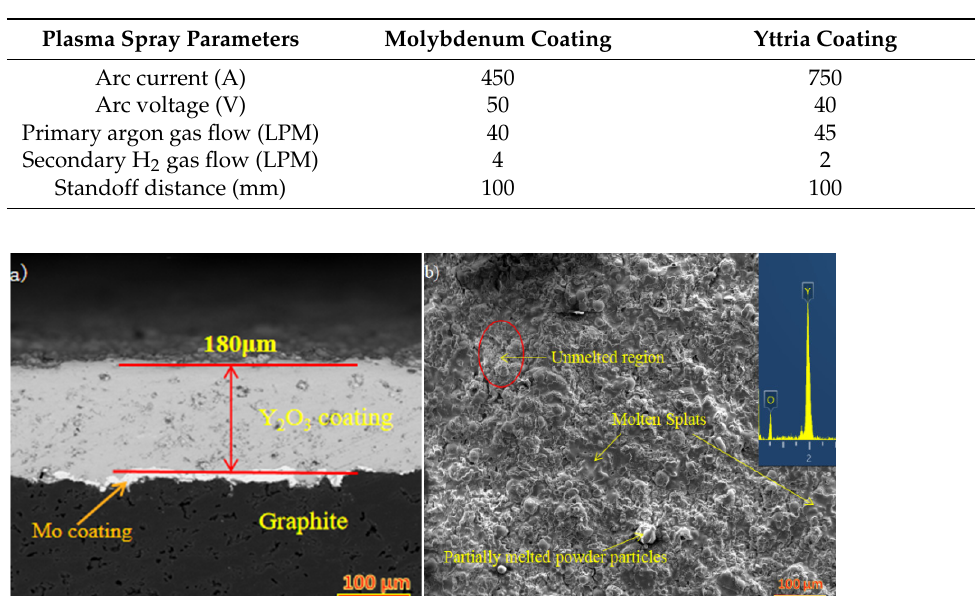
Table 1. Plasma spraying parameters of Mo transition layer and Y 2 O 3 coating.